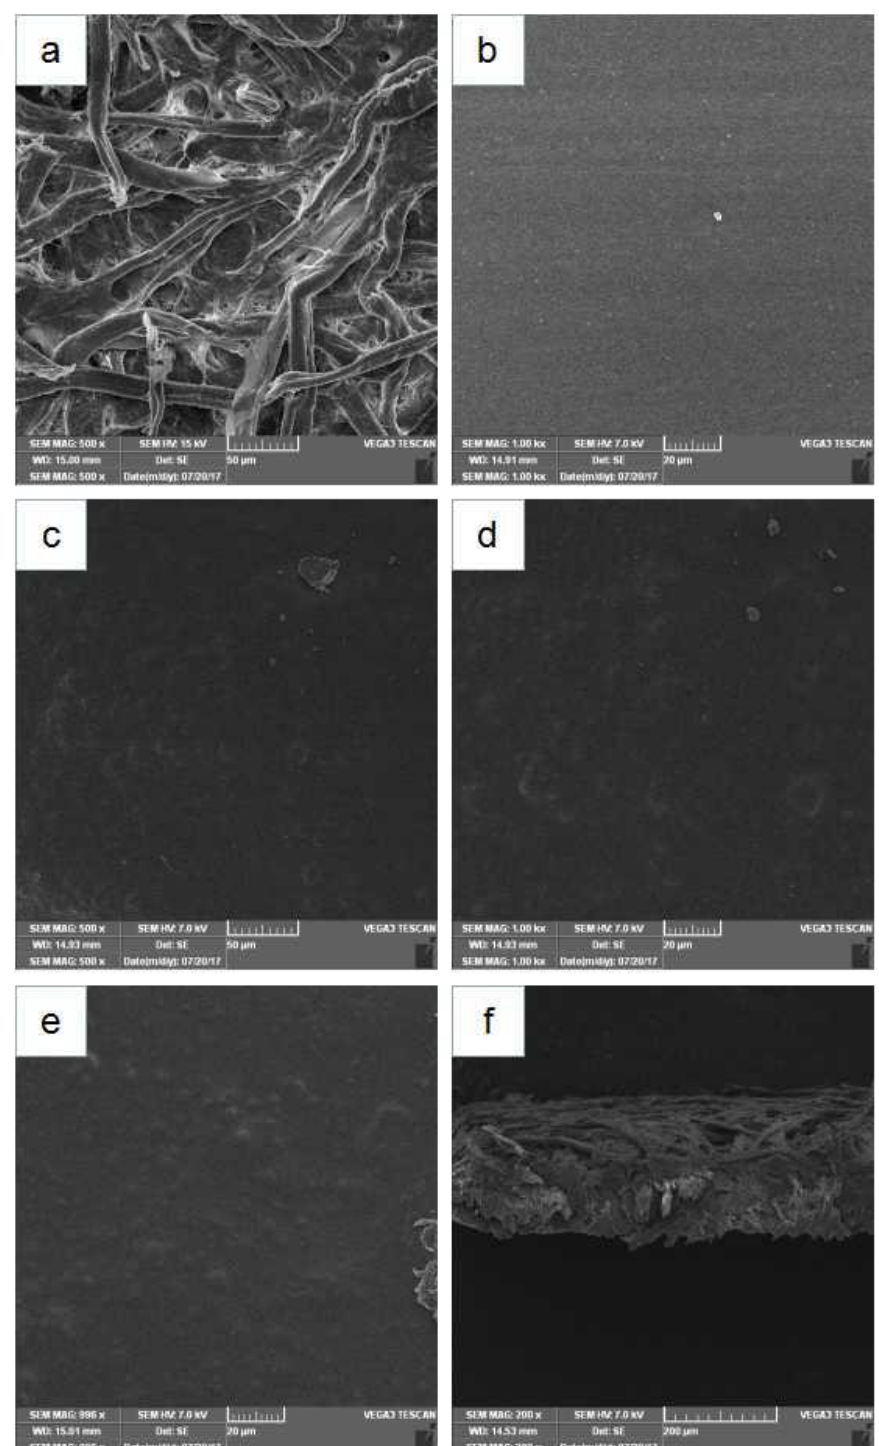
Figure 5. SEM images of antimicrobial pads, ( a ) Absorbent pads (surface), ( b ) The ethyl cellulose pads (surface), ( c ) The ethyl cellulose pads modified by permutite (surface), ( d ) The ethyl cellulose pads modified by Ag + /Zn 2+ -permutite (surface), ( e ) The ethyl cellulose pads modified by Ag + /Zn 2+ -permutite (surface), ( f ) The ethyl cellulose pads modified by Ag + /Zn 2+ -permutite (cross-sectional).